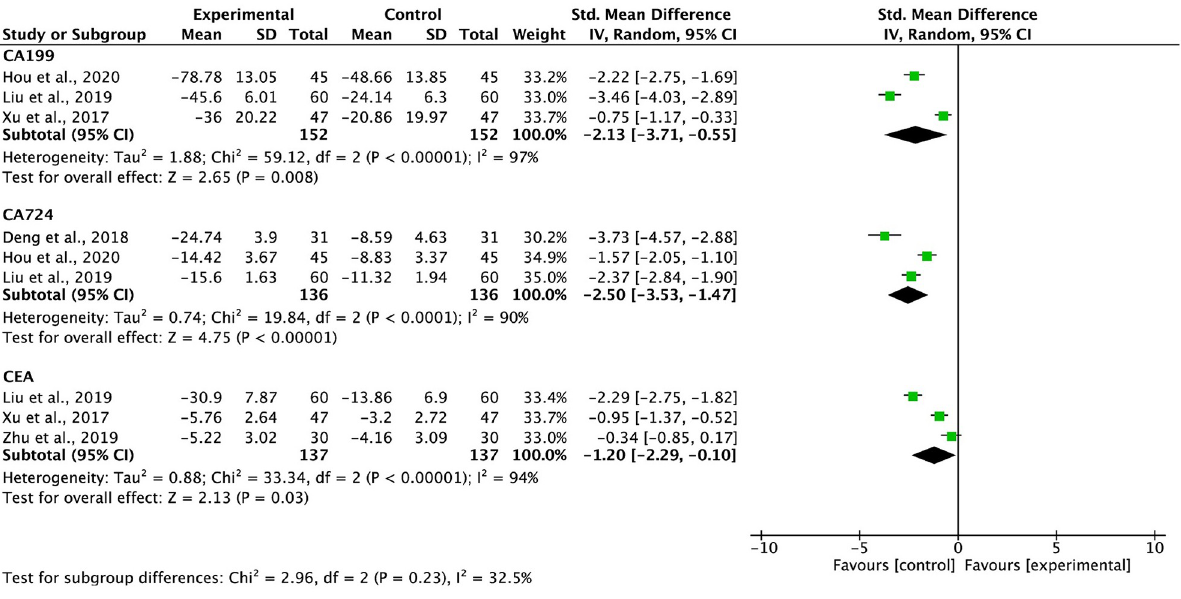
Fig 8. Meta-analysis results of cancer